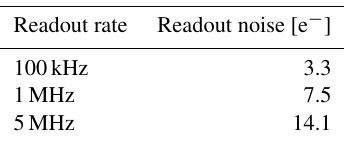
Table A4. Readout noise dependence of readout rate using the tra- ditional low noise amplifier. Values according to the Certificate of Performance of the PI ProEM512B camera at device L2, IRAMAT- CRP2A. Readout